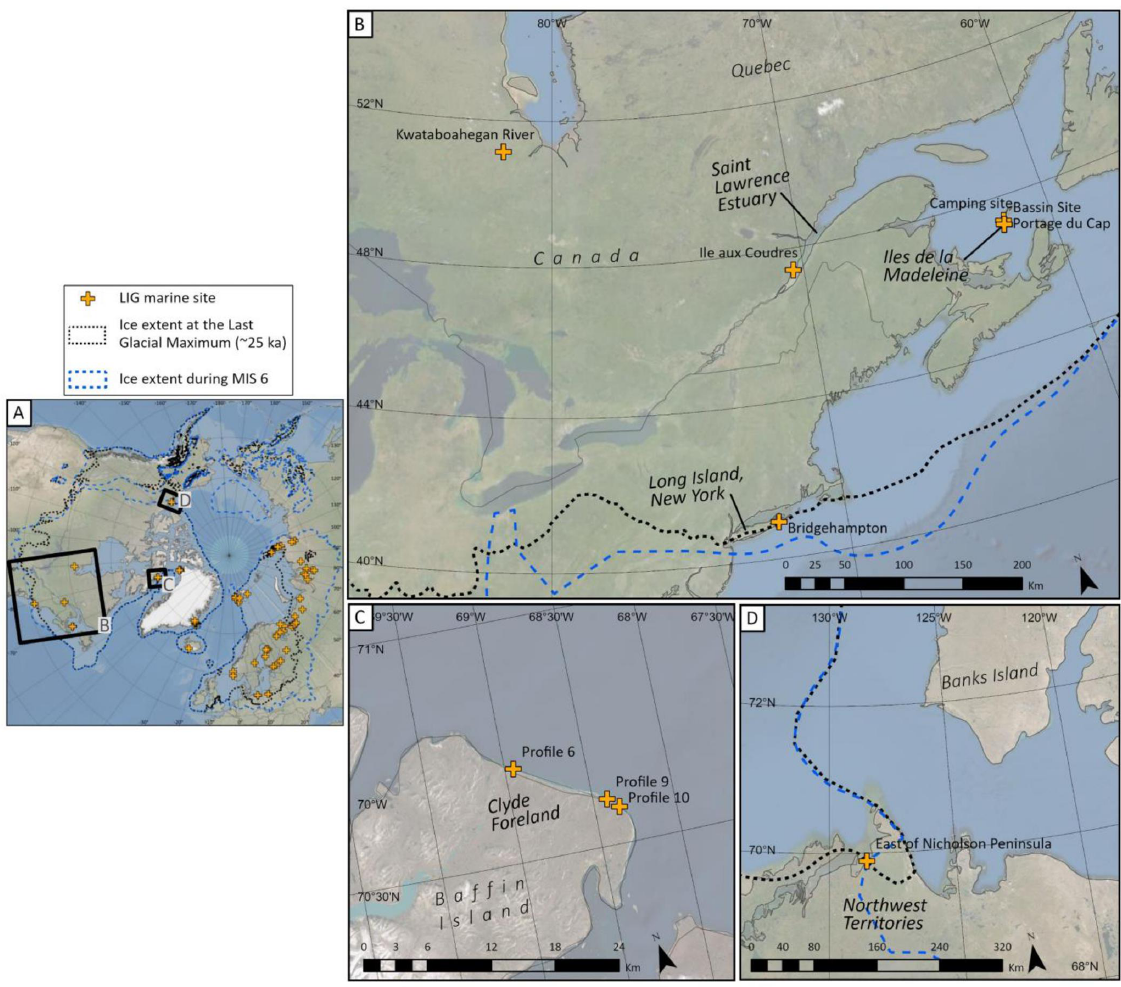
Figure 14. The locations of LIG marine sites in North America. Panel (a) situates the sites in the Northern Hemisphere, whereas panels (b) , (c) and (d) provide regional maps. Sites plotted on this map are detailed in Sect. 6.43–6.48. Extent of MIS 6 and Last Glacial Maximum ice sheets after Batchelor et al. (2019). Scale calculated at centre of mapped area. Base layer: ArcGIS World